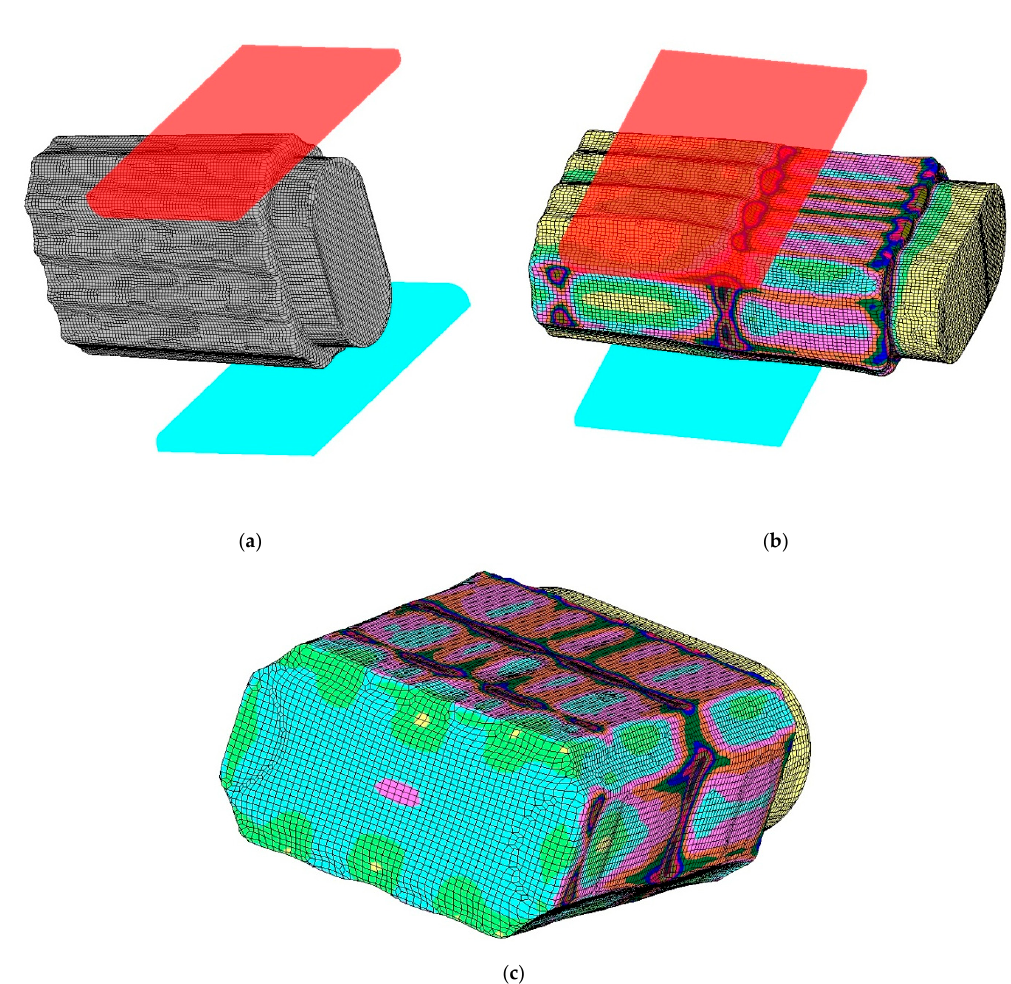
Figure 3. Forging process of a polygonal shape of surfaces of the P40N slab ingot to flat surfaces of billet. ( a ) Initial shape of the P40N ingot; ( b ) Flat surfaces billet; ( c ) The billet of 1550 mm width × 900 mm thickness.